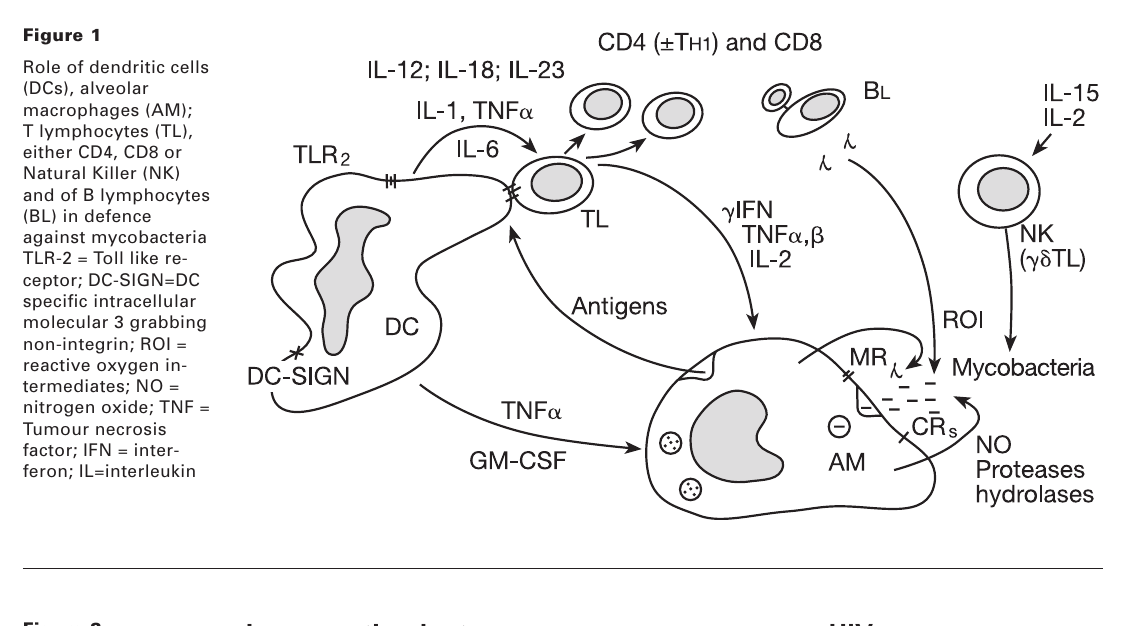
Complex interaction between host defences and elements, which will either up- or down-regulate their efficiency against